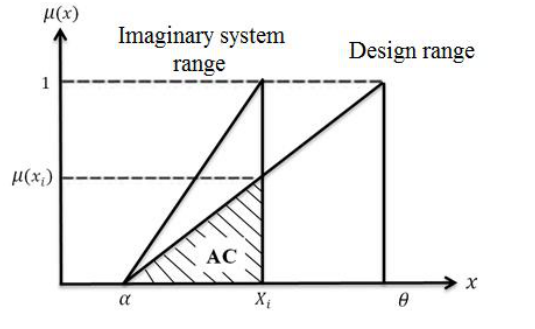
Figure 7. Triangular fuzzy range design and crisp range